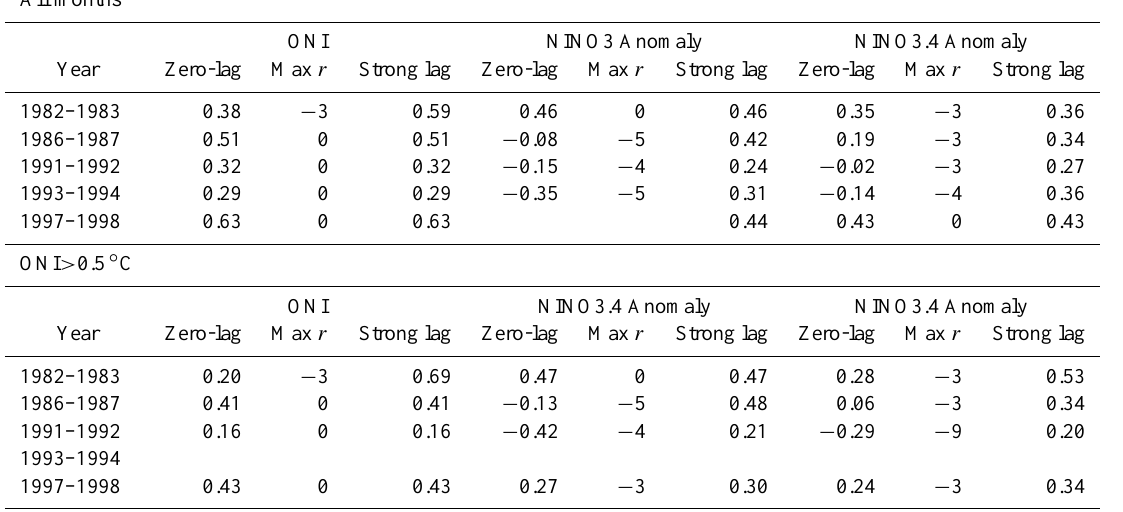
Table 4. Correlation ( r ) between monthly El Ni˜no strength (as measured by the ONI, NINO 3, and NINO 3.4 ENSO index anomalies) and fire activity (AF counts) during the five El Ni˜no events studied here; the two most significant in terms of El Ni˜no strength being those of 1982–1983 and 1997–1998. The upper table shows analyses based on all months during the episode, the lower only those where the ONI > 0.5 ◦ C (note in 1993–1994 there were multiple periods with ONI > 0.5 ◦ C and so only the entire episode was analysed). Zero-lag is the strength of association at lag=0; Max r is the lag with the strongest positive correlation and Strong lag the strength of the correlation in that month. All months ONI NINO3 Anomaly NINO3.4